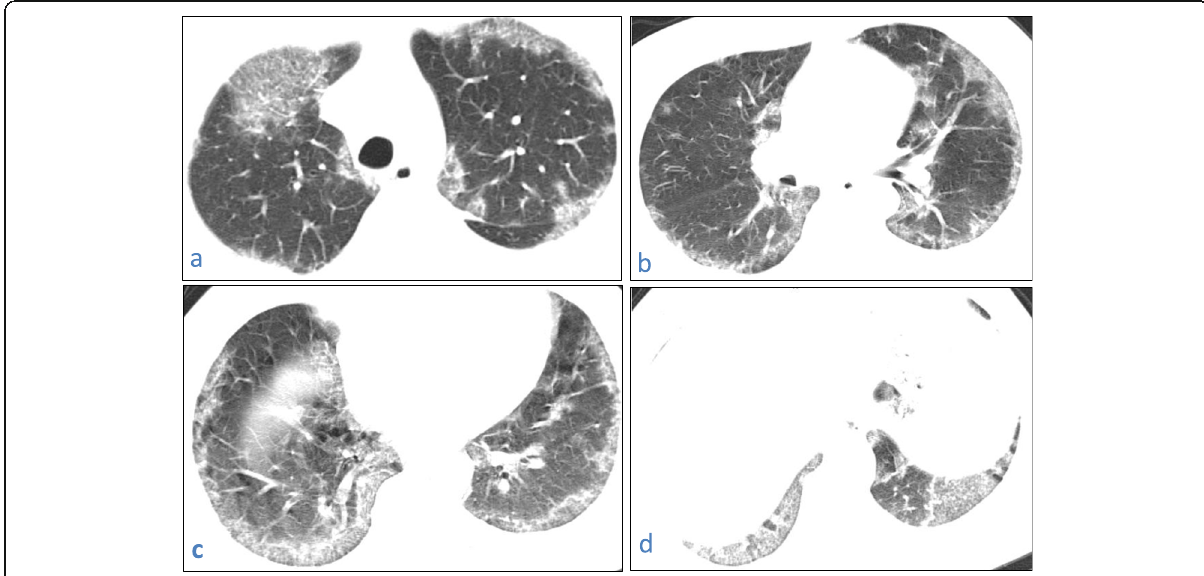
Fig. 10 A 67-year-old male patient with COVID-19, CT chest axial images ( a - d ) show predominantly subpleural crazy paving of all lobes with vascular thickening within. The affection is mostly in both lower